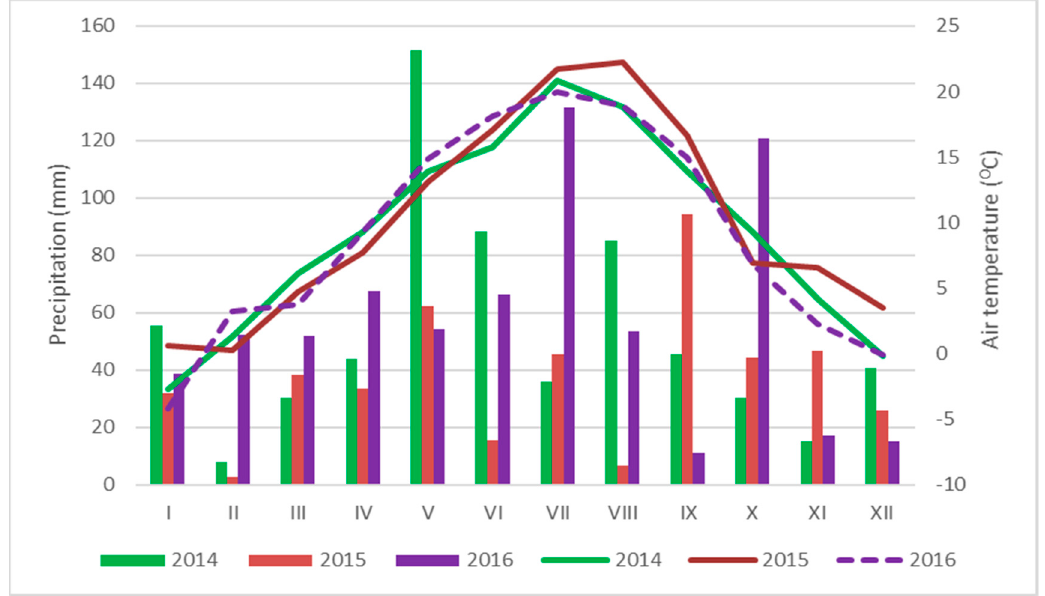
Figure 3. Monthly sums of precipitation and average air temperatures at the Uhrusk Experimental Station.